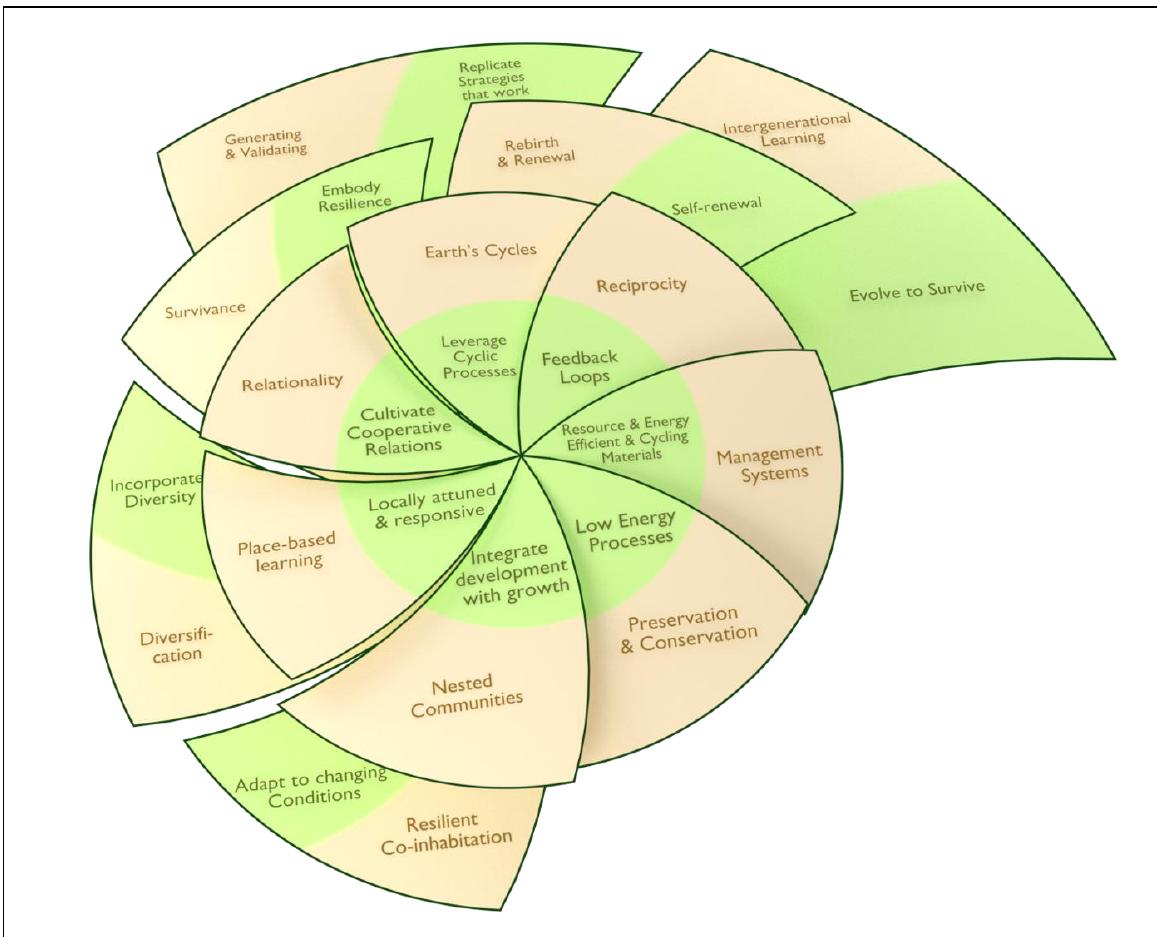
Figure 2. Regenerative Food System Spiral This represents the intersection between Traditional Ecological Knowledge (TEK) (brown) and Life ’s Principles (LPs) (green). The internal spiral is the base of 7 principles, the first tier is the expansion over time (one to two generations), and the second tier is the expansion over more time (across many generations). The spiral is a recurring pattern and symbol both in nature and in Indigenous communities, showing an optimal growth